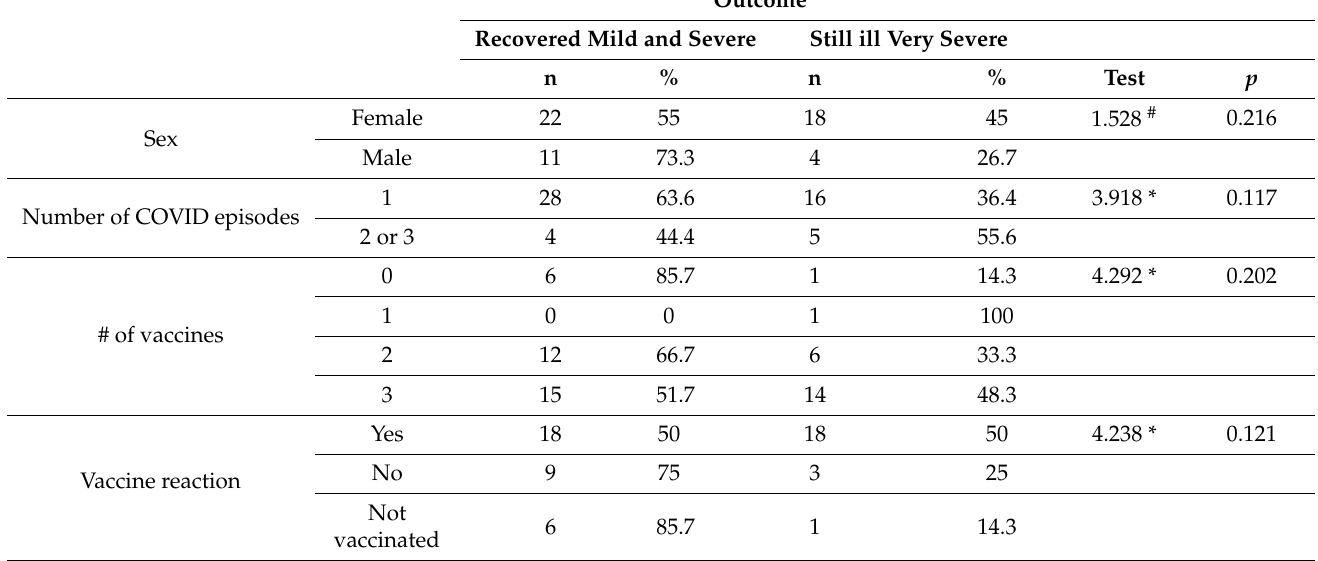
Table 2. Main characteristics describing a cohort of 55 clinically PACS patients who presented themselves in a family practice in Belgium, during 2021–2022. The characteristics of two groups; group 1: cured mild and severe long COVID versus group 2: still ill very severe long COVID, (see Table 1) were compared to each other using the appropriate statistical tests. Ordering of first SPECT-CT, gravity indicator (DUSOI) and functional status indicator (COOP) which are all clinical considerations seem to have significant relationships with the severity of the outcome. Second SPECT-CT is ordered only to still sick patients. Months after acute COVID are calculated at the last patient assessment, i.e., the month before the submitted data collection. Both show a relationship with the outcome, as